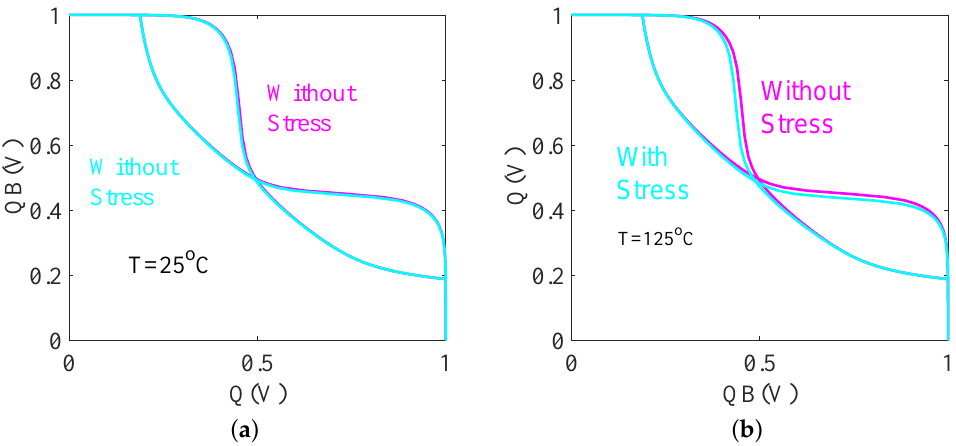
Figure 16. Degradation in RNM under 10 year NBTI stress at ( a ) T = 25 °C. ( b ) T = 125 °C.